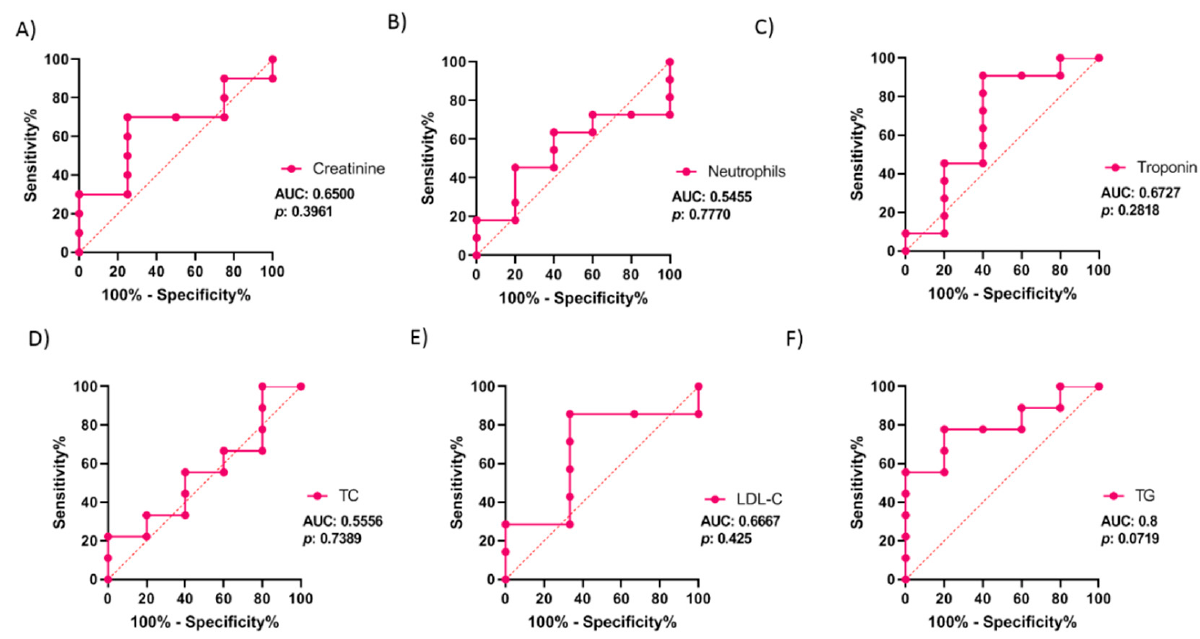
Figure 6. ROC analysis from hemodynamic parameters in patients’ group. ( A – F ) Graphs illustrate area under the curve (AUC) analysis of ROC indicating sensitivity and specificity of creatinine ( A ), neutrophils ( B ), troponin ( C ), total cholesterol (TC; D ), Low-Density Lipoprotein cholesterol (LDL-C; E ), Triglyceride (TG; F ). Values are given on the graphs. Rose color indicates ISR patients.